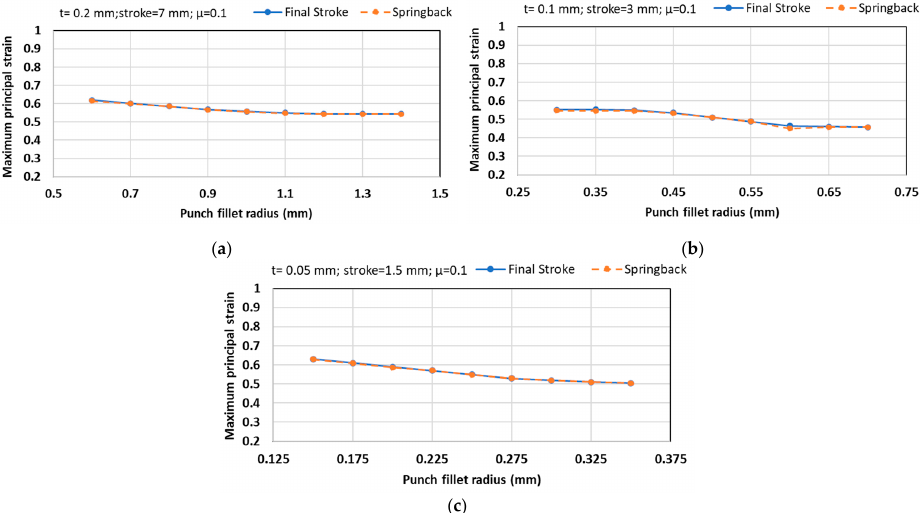
Figure 12. The relationship between the punch fillet radius and the maximum principal strain: ( a ) Model 1; ( b ) Model 2; ( c ) Model 3.